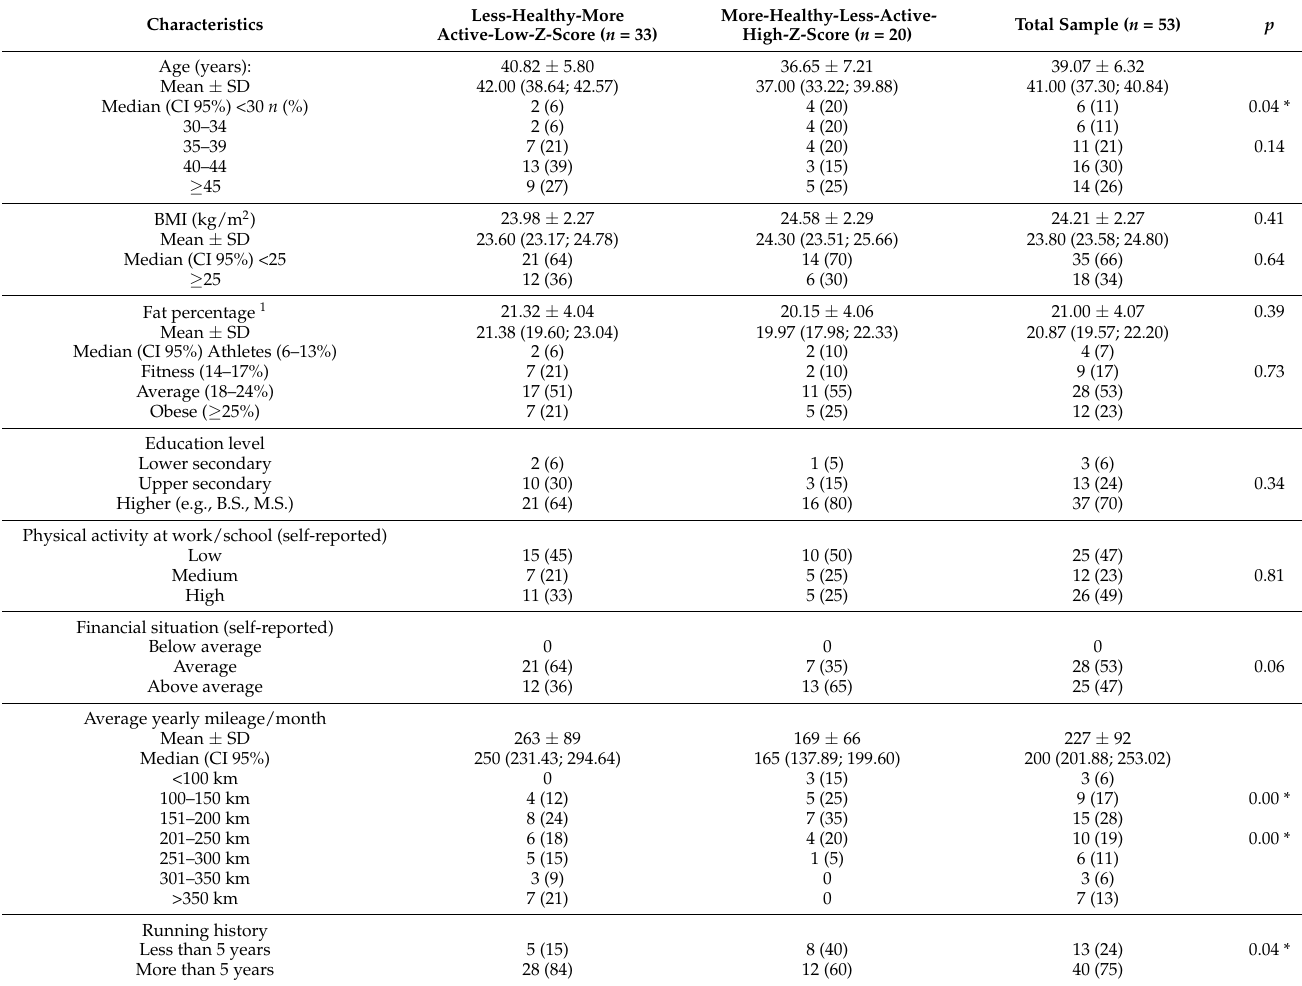
Table 2. Characteristics of the total study sample and comparisons between